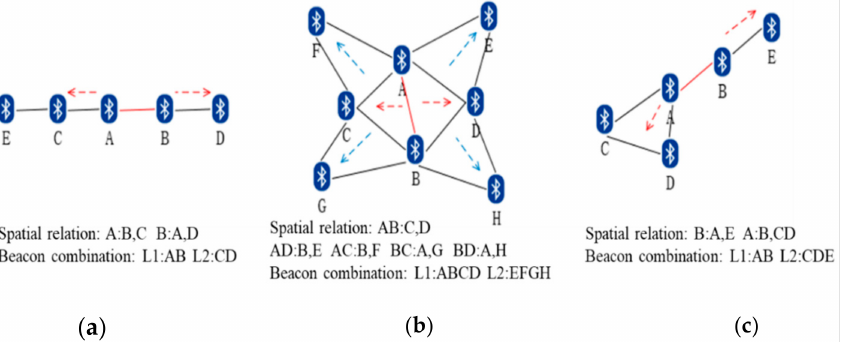
Figure 7. The optimal reference beacon combination in the area-AB under different layouts: ( a ) linear layout, ( b ) polygonal layout, ( c ) mixed layout.